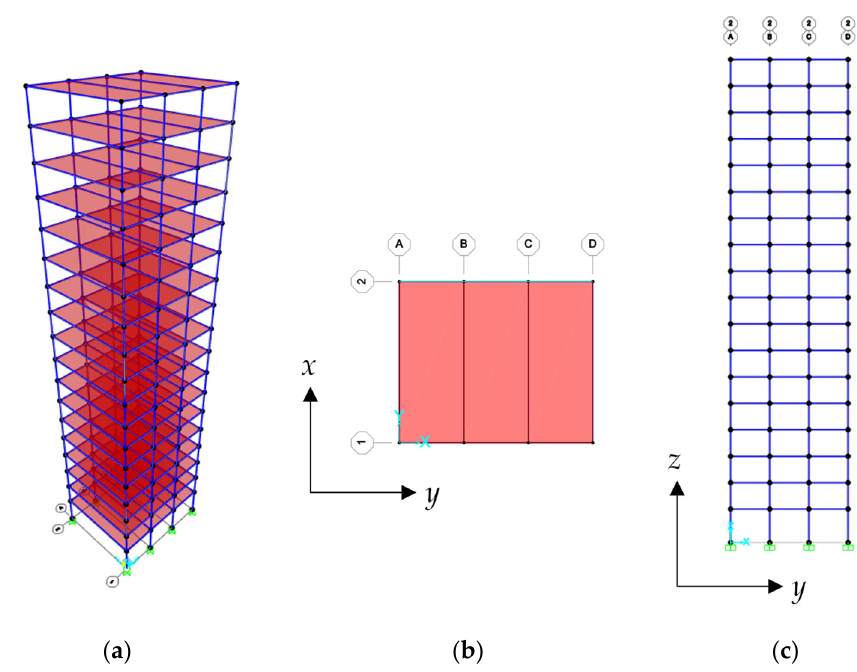
Figure 4. The 18-story steel experimental structural analysis model: ( a ) Three-dimensional view; ( b ) plan view; ( c ) elevation view ( y -axis).